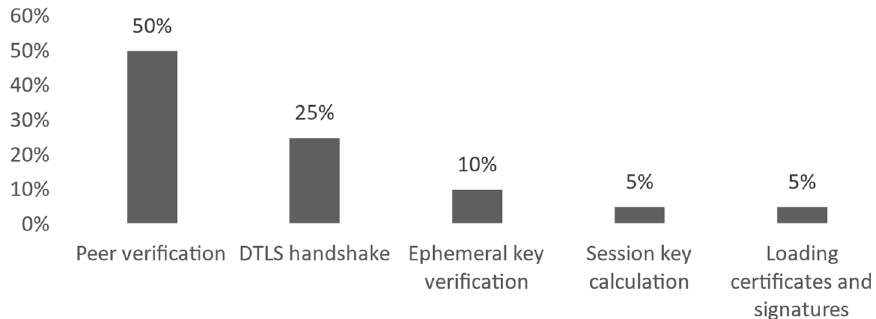
Figure 9. IoT-Crypto computation overhead divided into categories.